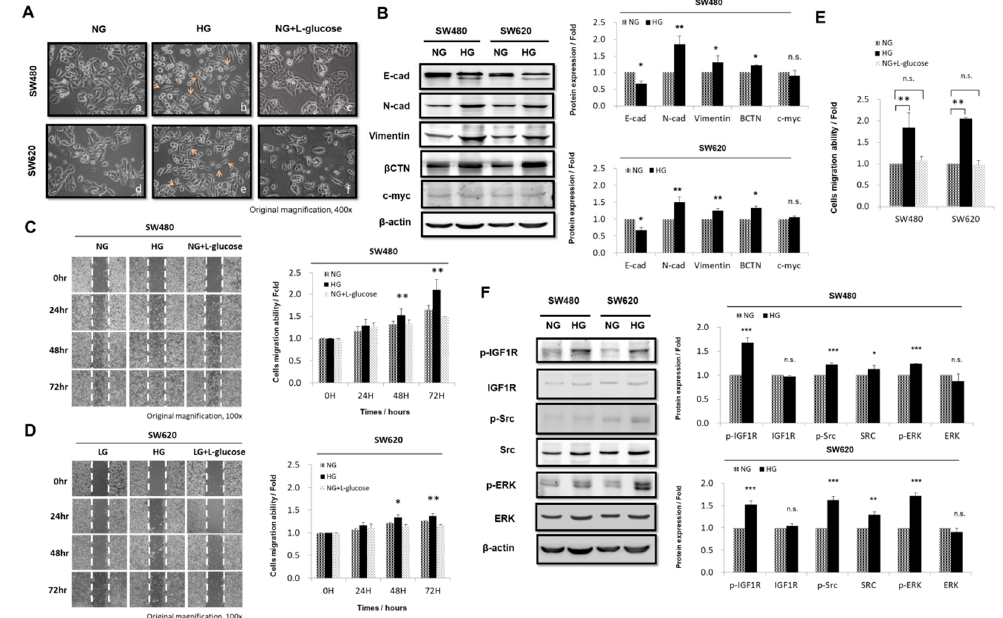
Figure 2. High glucose (HG) concentrations induced epithelial-to-mesenchymal transition protein expression and enhanced migration activity in colorectal cancer (CRC) cells. SW480 (low metastatic potential) and SW620 (high metastatic potential) cells were cultured in different concentrations of glucose (normal: NG; HG; and osmotic control: NG + L -glucose). ( A ) Morphological change occurred from epithelial to mesenchymal type in the HG-concentration group. ( B ) HG concentration caused downregulation of E-cadherin and upregulation of N-cadherin, β CTN, and vimentin, but c-myc was unchanged, as detected using Western blotting. β -actin was evaluated as an internal control. ( C , D )